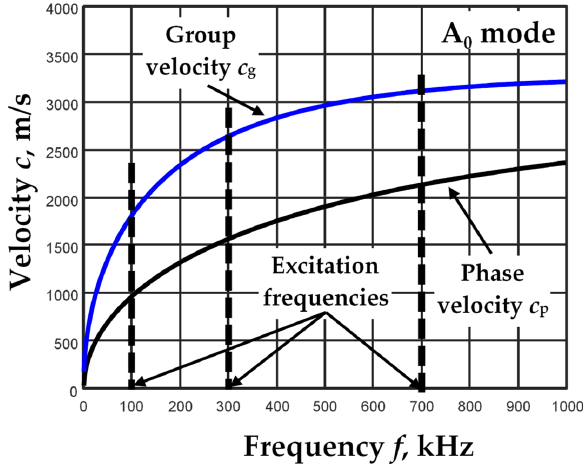
Figure 5. The Lamb wave A 0 mode group and phase velocity dispersion curves in 1 mm thick aluminum plate, calculated using the one-dimensional SAFE method.